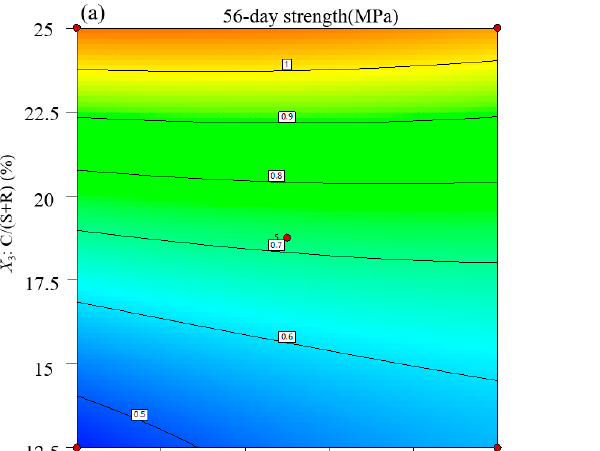
Figure 8. Response surface analysis of influential factors on backfill strength at 28 days: ( a ) contour lines; ( b ) response surface.